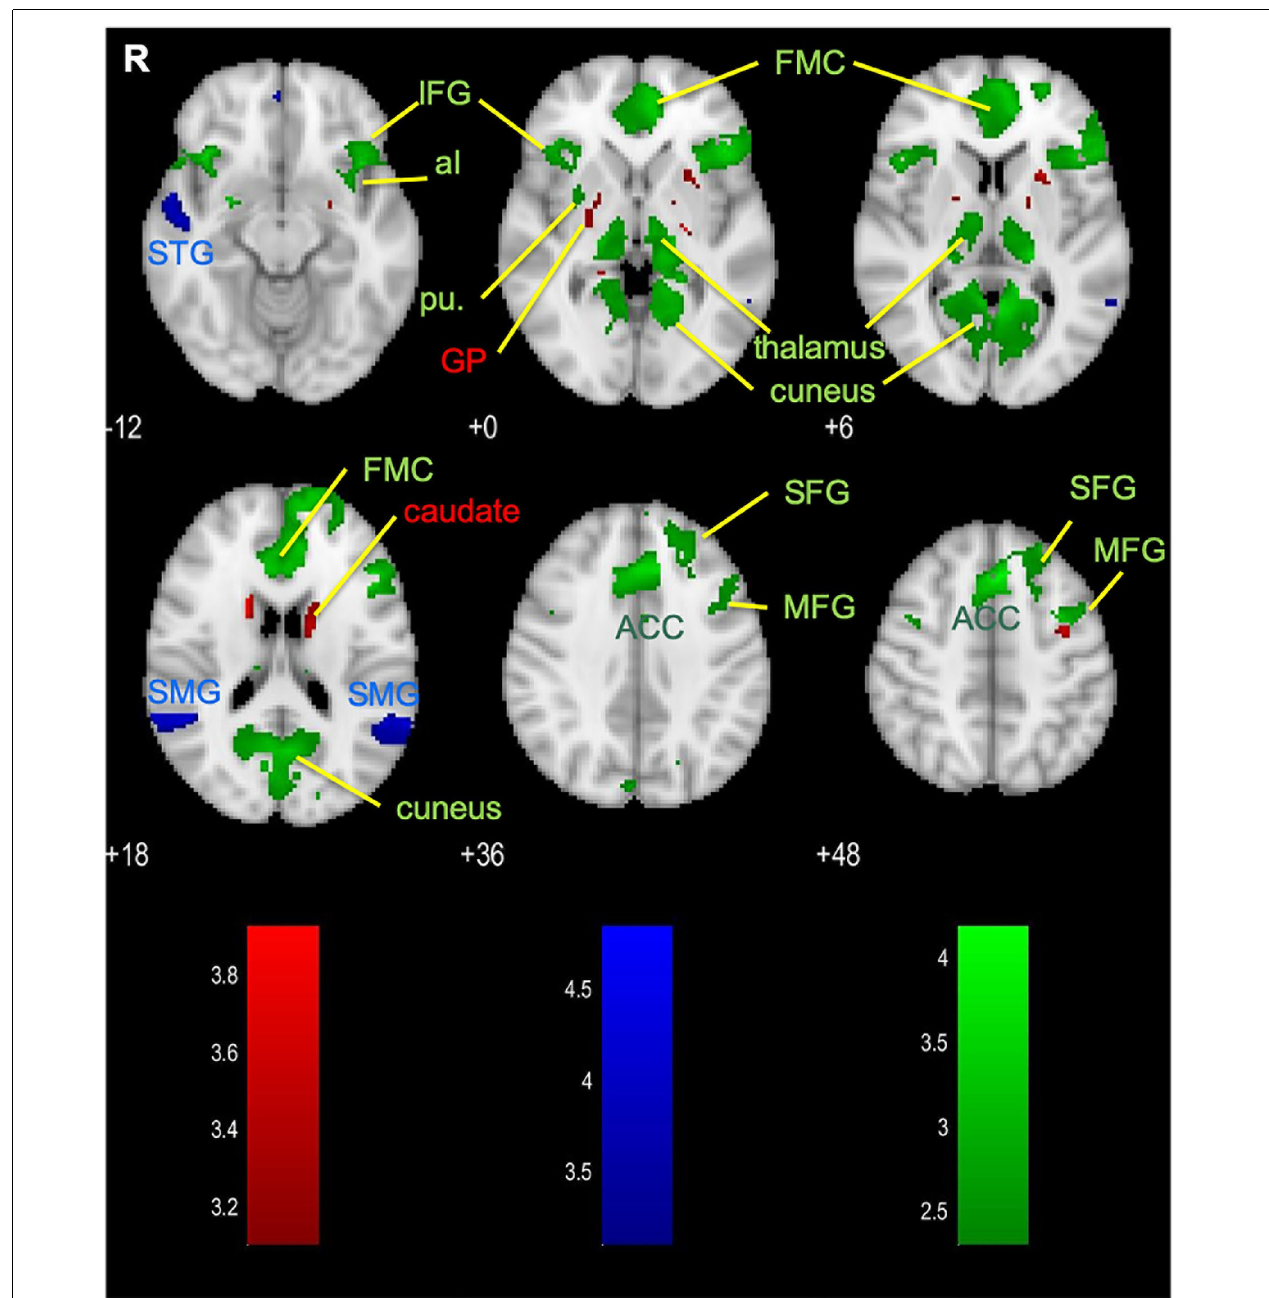
FIGURE 4 | Brain areas that are dominantly activated in the disjunction of parallel paradigm (red), serial paradigm (blue), and the conjunction of the parallel and the serial paradigms (green). ACC, anterior cingulate cortex; aI, anterior insula; FMC, frontal medial cortex; GP, globus pallidus; IFG, inferior frontal gyrus; MFG, middle frontal gyrus; pu, putamen; SFG, superior frontal gyrus; SMG, supramarginal gyrus; STG, superior temporal gyrus.